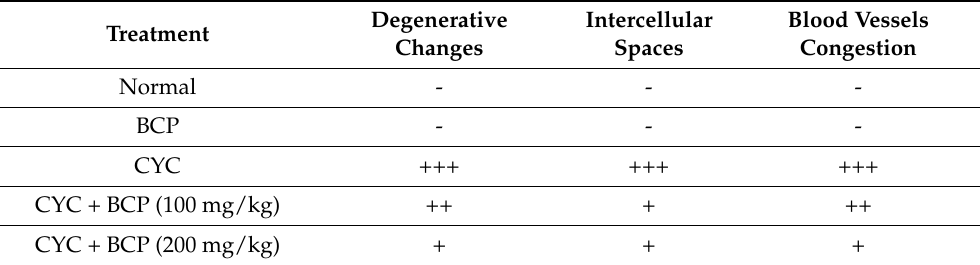
Table 3. Effects of treatment with β -caryophyllene (BCP) for 14 days on cyclophosphamide (CYC) induced fluctuations in histology of the cardiac